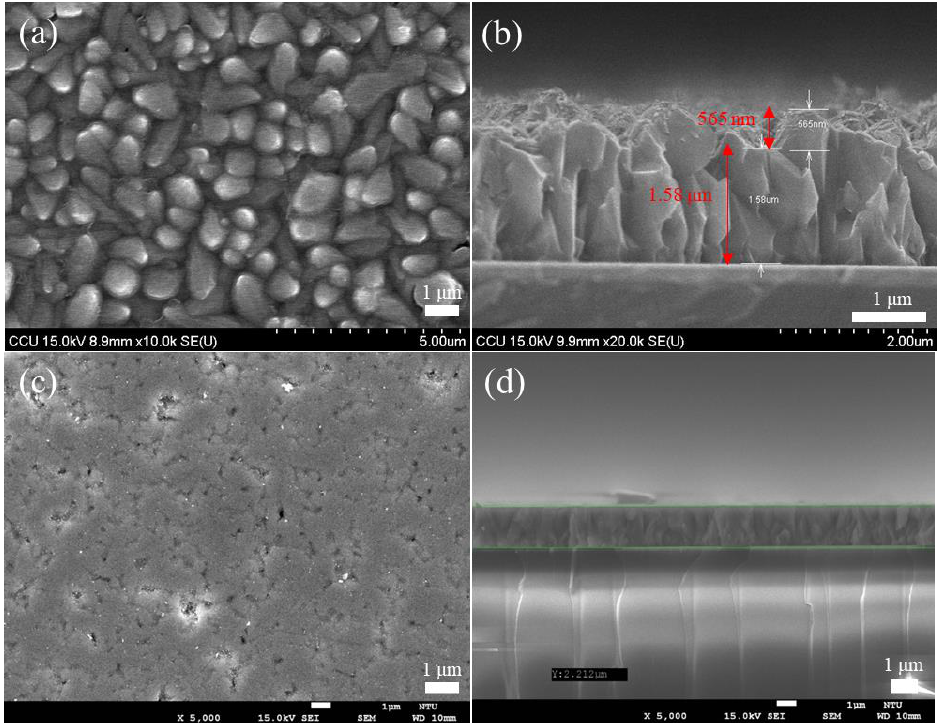
Figure 3. ( a ) Represents the front view of the Cu 2 O film before polishing, ( b ) represent the side view of the Cu 2 O film before polishing, ( c ) show the SEM images of the top view after Cu 2 O polishing, ( d ) show the SEM images of the front view after Cu 2 O polishing.